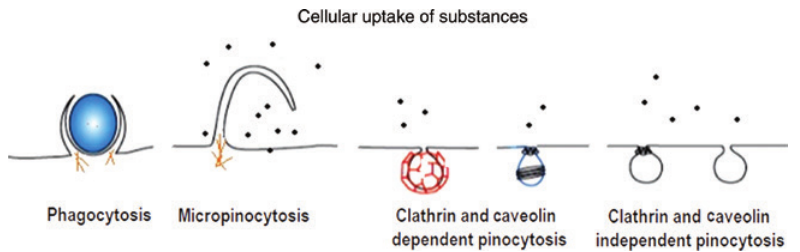
Figure 4: Different modes in which a cell can uptake substances. A similar mechanism is what nanoparticles are expected to